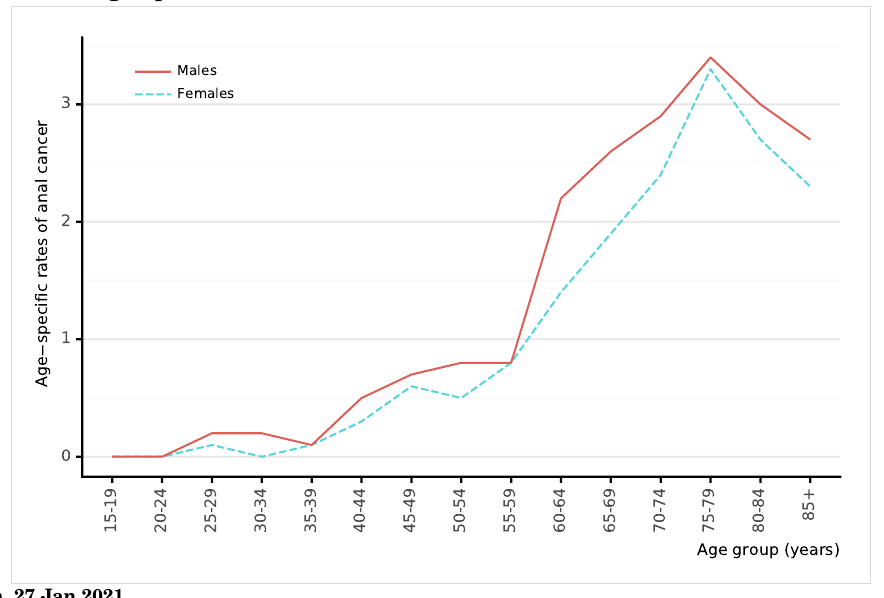
Figure 15: Age-specific incidence rates of anal cancer in India (estimates for 2020)